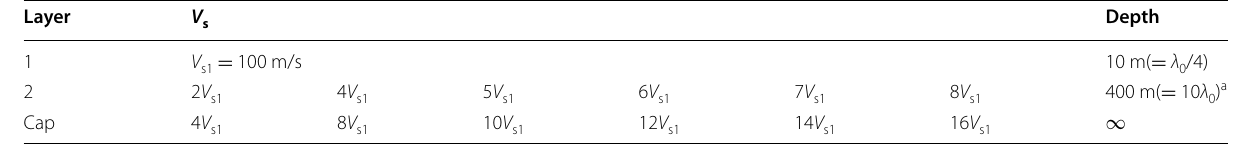
a The thickness of second layer is infinite for two-layered medium